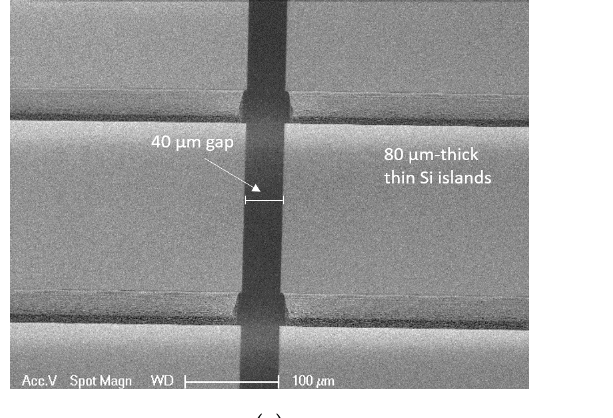
Figure 10. DBS demonstrator wrapped into a cylindrical probe with a length of 18 mm and a di- ameter of 1.2 µm. 5. Conclusions Advanced cavity-BOX SOI substrates with a buried oxide mask were developed, pre- pared, and applied in the process of a semiflexible microfabricated device. The oxide mask was first fabricated on the handle wafer and then bonded with the oxide on the device layer to form the cavity-BOX. The alignment between the structures on the device layer and the buried oxide mask was successfully realized by employing the front-to-front markers transferring strategy. The advanced SOI substrate was implemented for a DBS demonstrator fabrication. The cavity-BOX layer was used as an etch-stop layer and a pre- patterned two-step DRIE mask to etch through the device layer from the backside of the wafer. This two-step oxide layer was successfully used to compensate for etch rate differ- ences during the bulk of the silicon removal. The application of the cavity-BOX substrate to the DBS demonstrator fabrication proved a more robust and significantly simplified process and large design freedom, including the coexistence of high-precision micron- sized features and a large millimeter-sized opening. The semiflexible DBS demonstrator